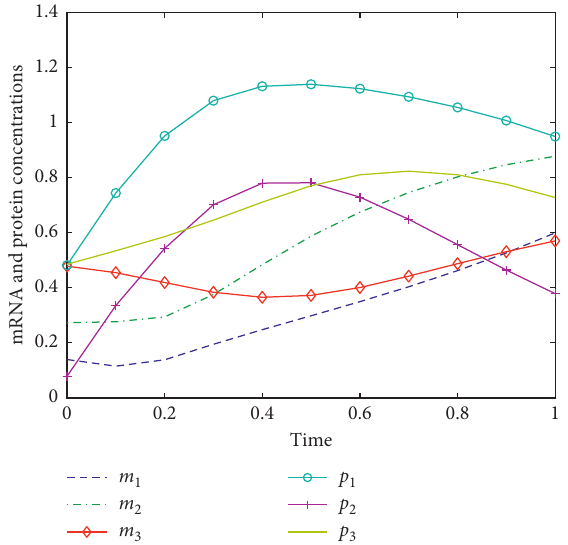
Figure 6: Transient states of DFGRN (66) with q � 0 . 40 and τ Table 1: The “estimated time” T